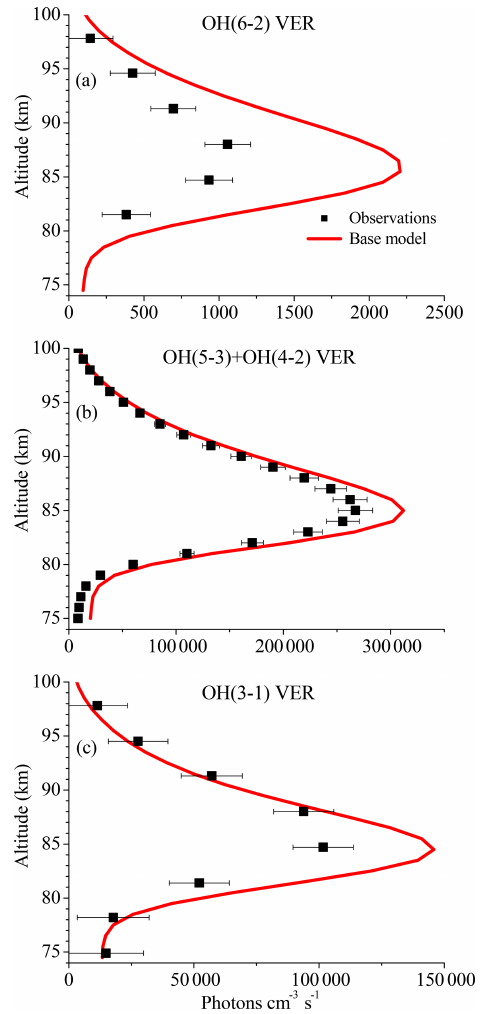
Figure 1. Comparison of vertical profiles of the volume emission rate (VER) of (a) OH(6-2), (b) OH(5-3) + OH(4-2), and (c) OH(3-1) at 0–10 ◦ N between satellite observations and the base model out- put. The observations are the climatology of night-time mean zonal means from 2003 to 2011, based on co-location measurements of TIMED/SABER and ENVISAT/SCIAMACHY. Note the different scaling of the x axis.